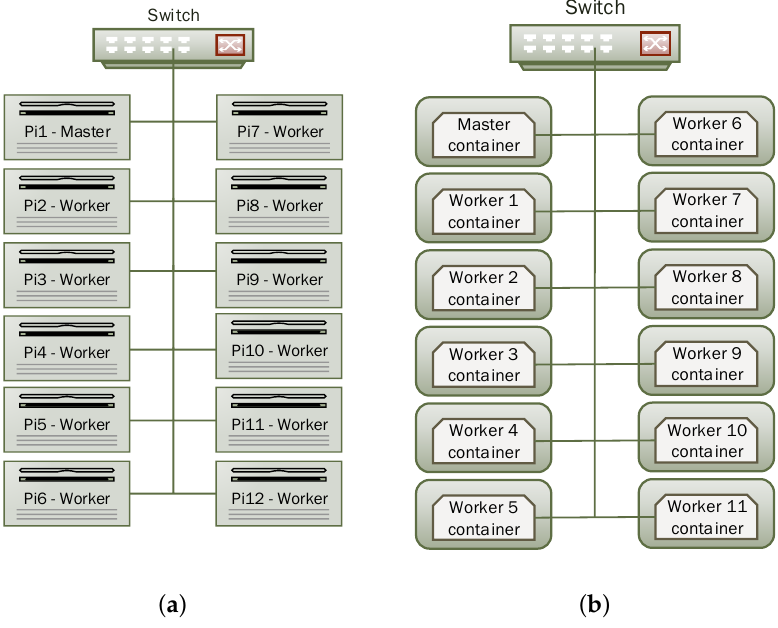
Figure 3. Cluster Layout. ( a ) Native set-up; ( b ) Virtualised